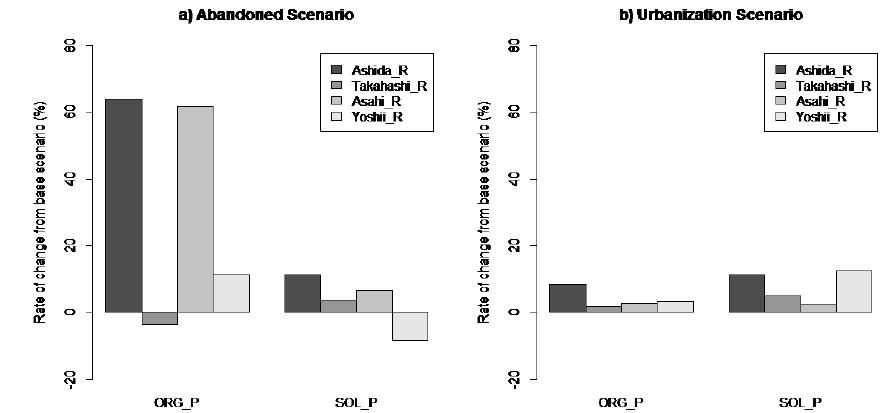
Figure 5. Rate of change in phosphorus discharge in different pathways. (a) Abandoned scenario, (b) urbanization scenario.